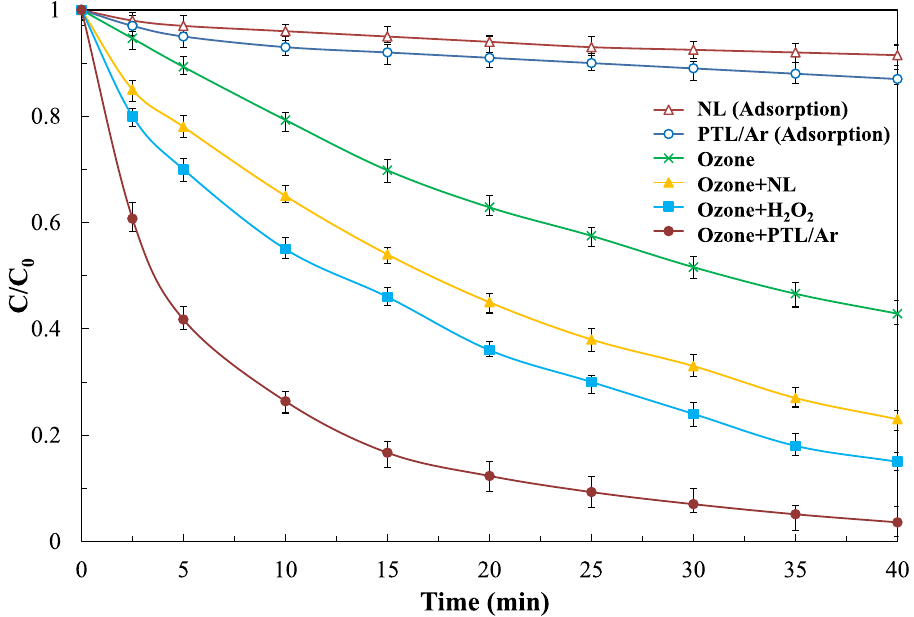
Figure 9. Comparison of PhP degradation efficiency with different oxidation processes ([PhP] 0 = 30 mg/L, [O